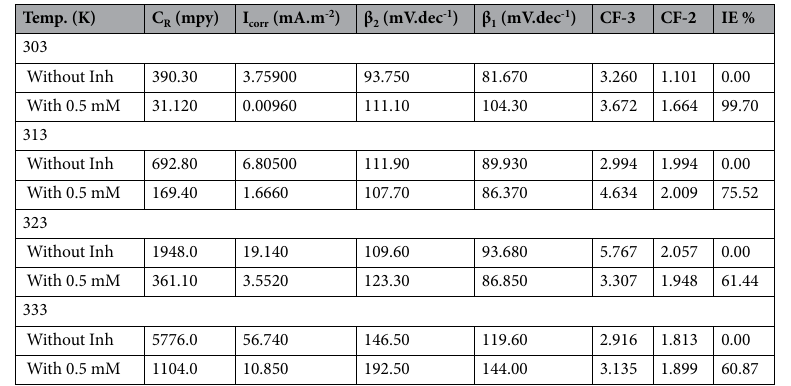
Table 8. EFM parameters for MS in 1.0 M HCl with 0.5 mM nonanedihydrazide at